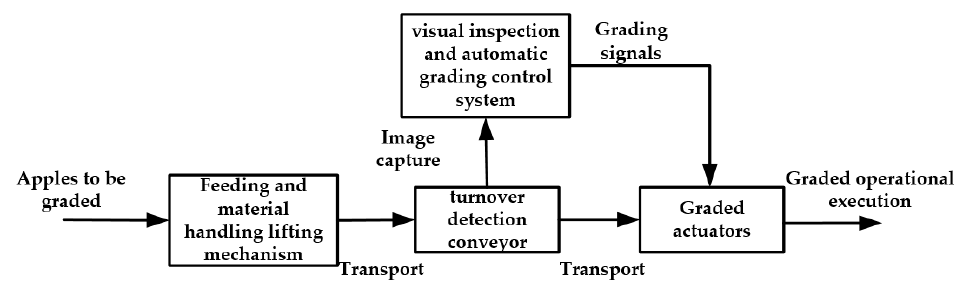
Figure 17. Workflow diagram for automatic apple grading.